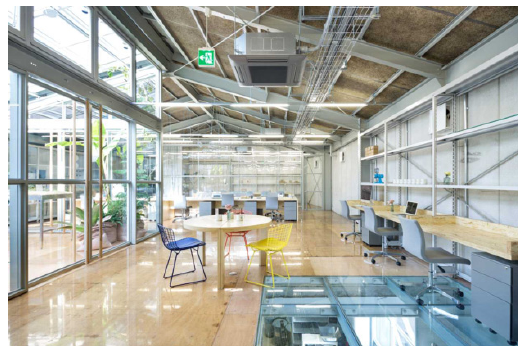
Figure 34. Blue Bottle in Kiyosumi [85].